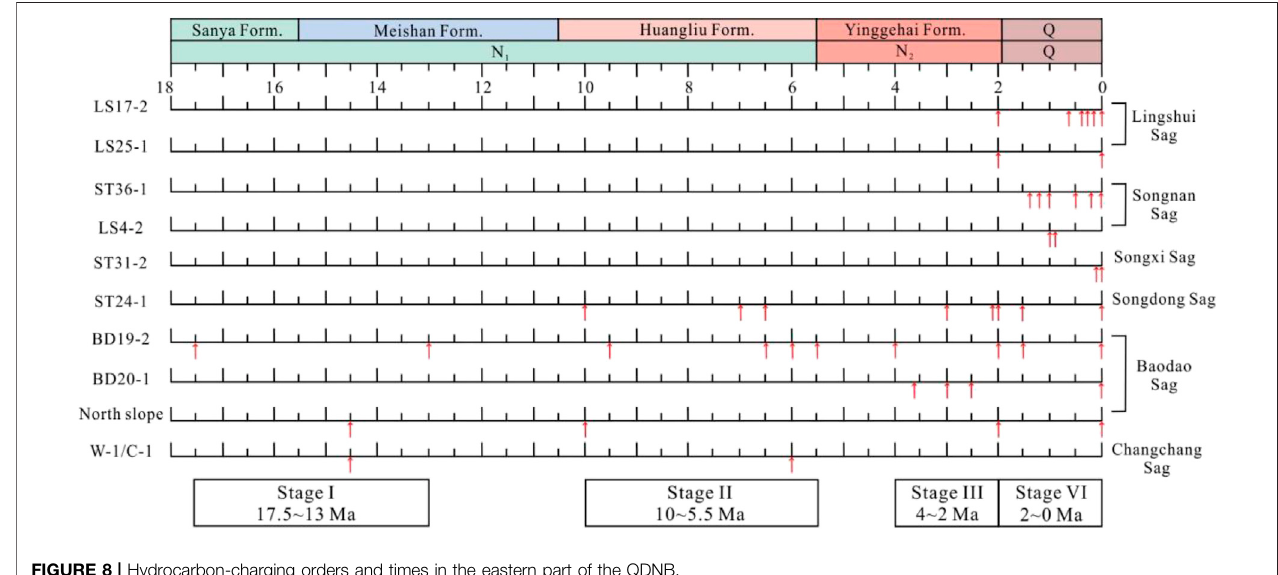
FIGURE 8 | Hydrocarbon-charging orders and times in the eastern part of the QDNB.